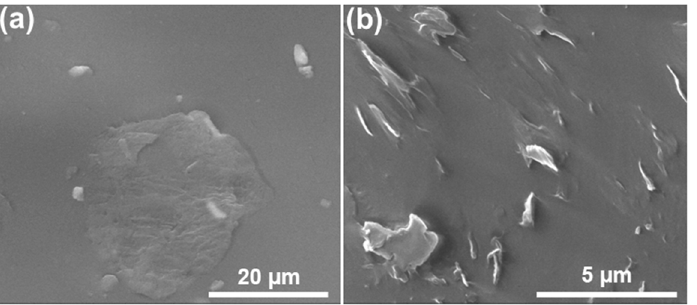
Figure 3. SEM images of the DOP-modified GNPs/NR rubber composite: ( a ) surface of the GNPs/NR rubber composite and ( b ) cross-section SEM image of the GNPs/NR rubber composite.